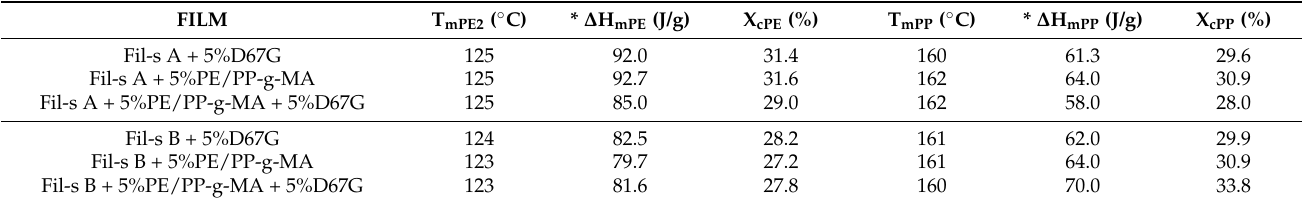
Table 6. Thermal data relative to the first heating scan (where T mPE , ∆ H mPE , X cPE and T mPP , ∆ H mPP , X cPP are the melting temperatures, enthalpies and crystallinity degrees of PE and PP fractions, respectively) for Fil-s A and Fil-s B-based films. The standard deviations of the thermal data were less than 5%.